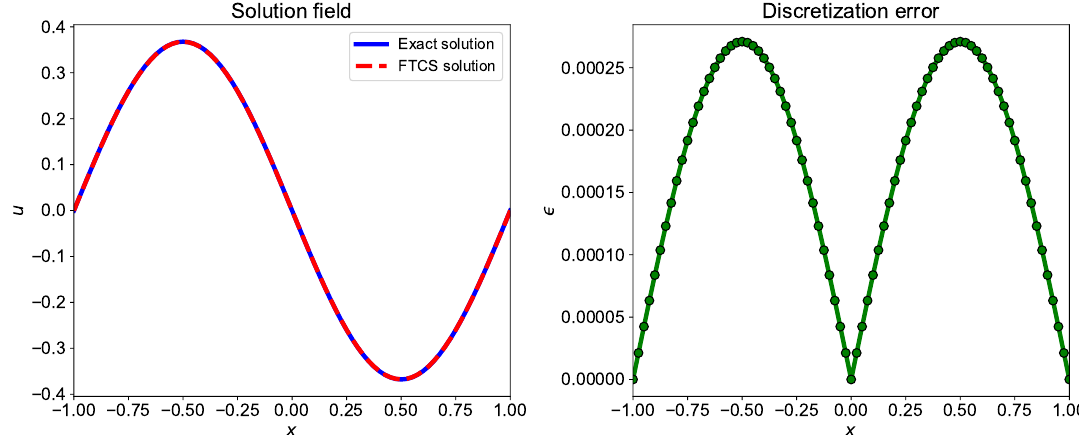
Figure 2. Comparison of exact solution and numerical solution computed using FTCS numerical scheme. The numerical solution is computed using ∆ t = 0.0025 and ∆ x =